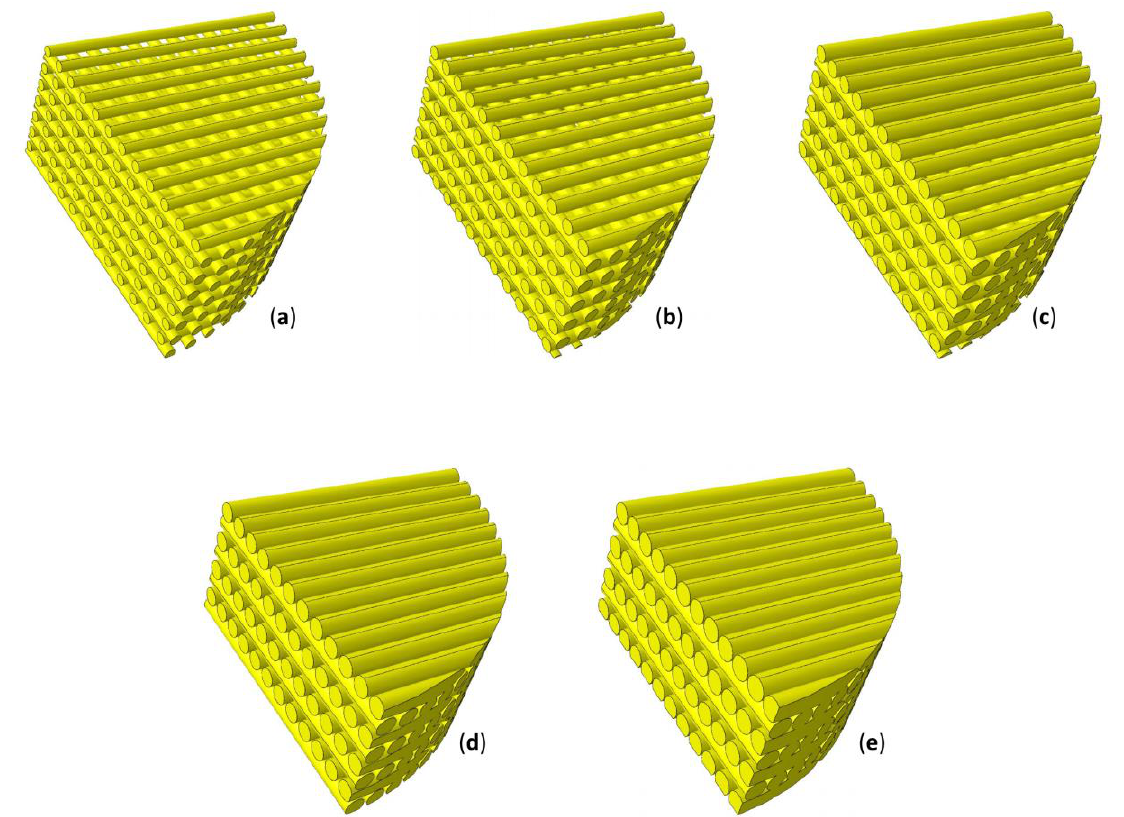
Figure 2. Models of scaffold investigated in the study including strands with diameter D = 400 µm ( a ), 500 µm ( b ), 600 µm ( c ), 700 µm ( d ), and 800 µm ( e ). The distance between the filaments was computed by means of the proposed optimization algorithm.